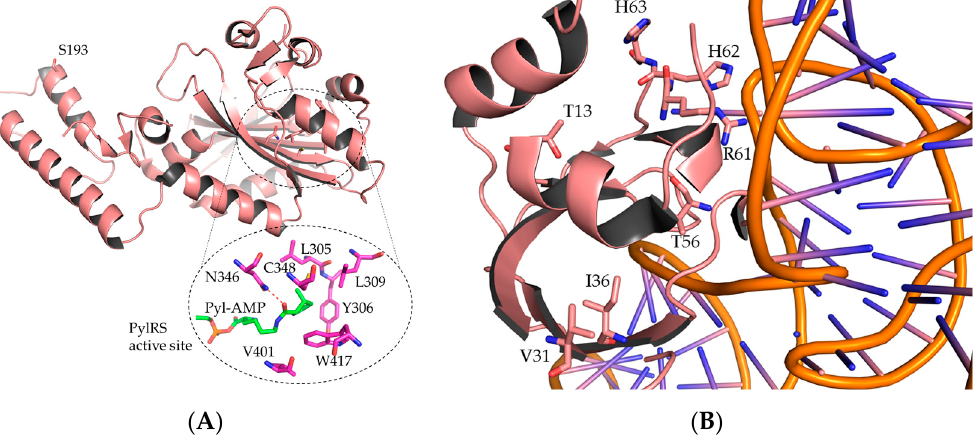
Figure A1. Crystal structure of wild-type Mm PylRS and Mm PylRS–tRNA Pyl complex (PDB ID 2Q7H and 5UD5). ( A ) Molecular microenvironment of residue S193 located outside of the active site pocket but in the C-terminal tRNA binding domain. ( B ) Additional aaRS residues T13, V31, I36, T56, R61, H62, and H63 located in the Mm PylRS N-terminal domain and important for activity in vivo.